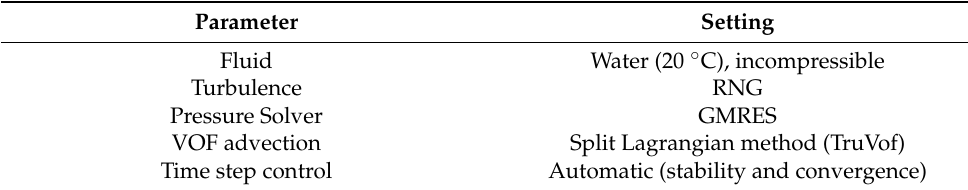
Table 4. General Parameter settings in CFD numerical simulation.